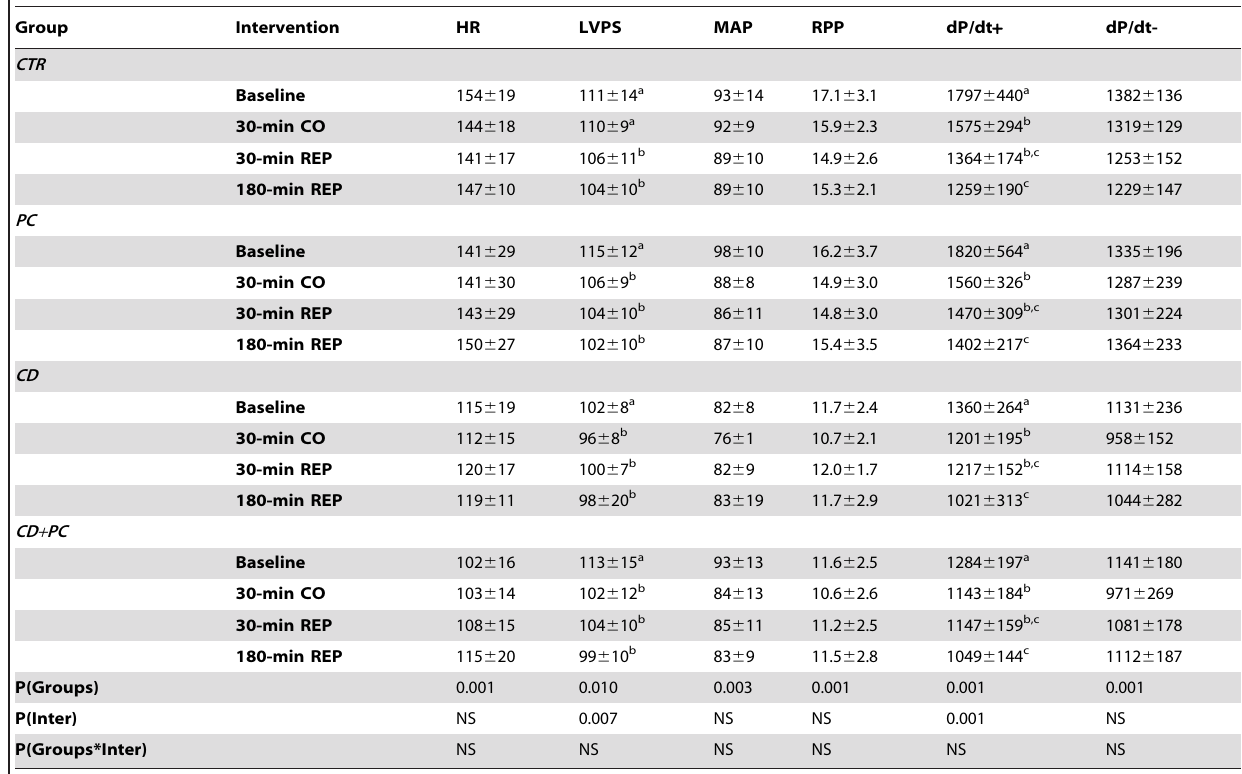
Table 1. Summary of cardiac hemodynamic